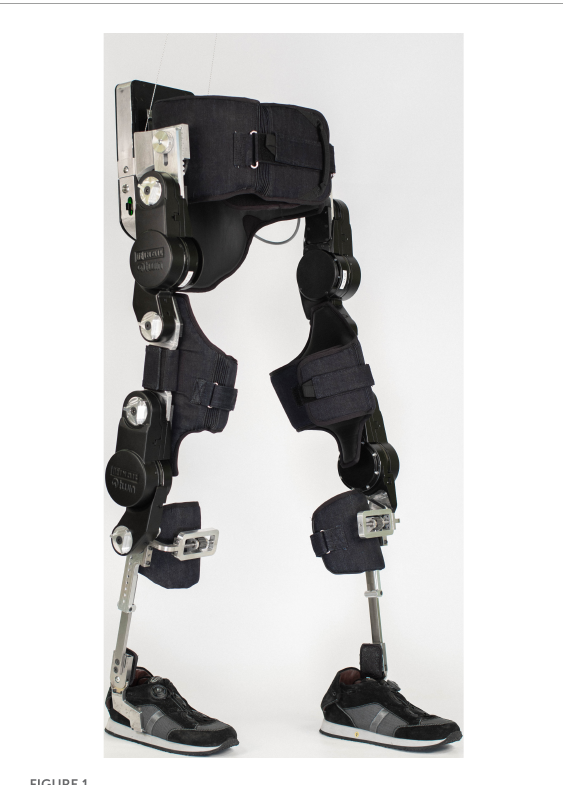
FIGURE1 The TWIN lower limb